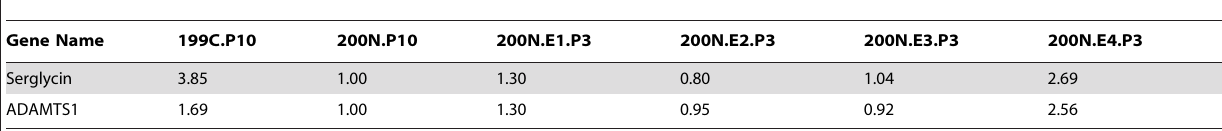
Table 1. Relative gene expression of serglycin and